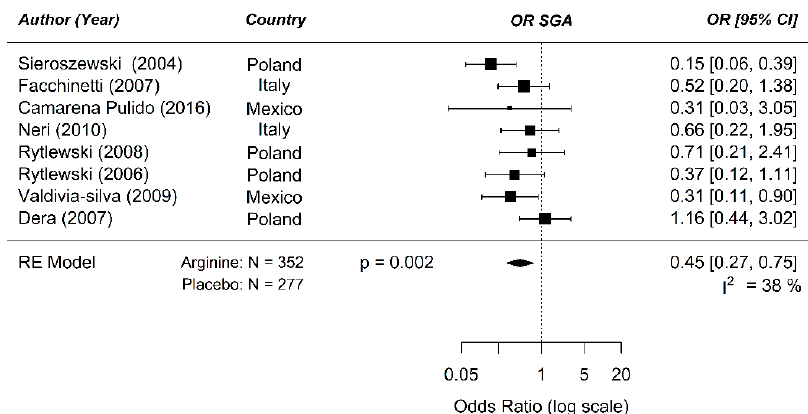
Figure 4. Meta-analysis on the prenatal supplementation of arginine on the development of small for gestational age (SGA) in a human risk population: The odd ratio (OR) for developing SGA in a risk population was 0.45 following arginine supplementation during pregnancy compared to placebo (95% confidence interval (CI) 0.27; 0.75) using a random effect model. Residual I 2 for heterogeneity is shown.